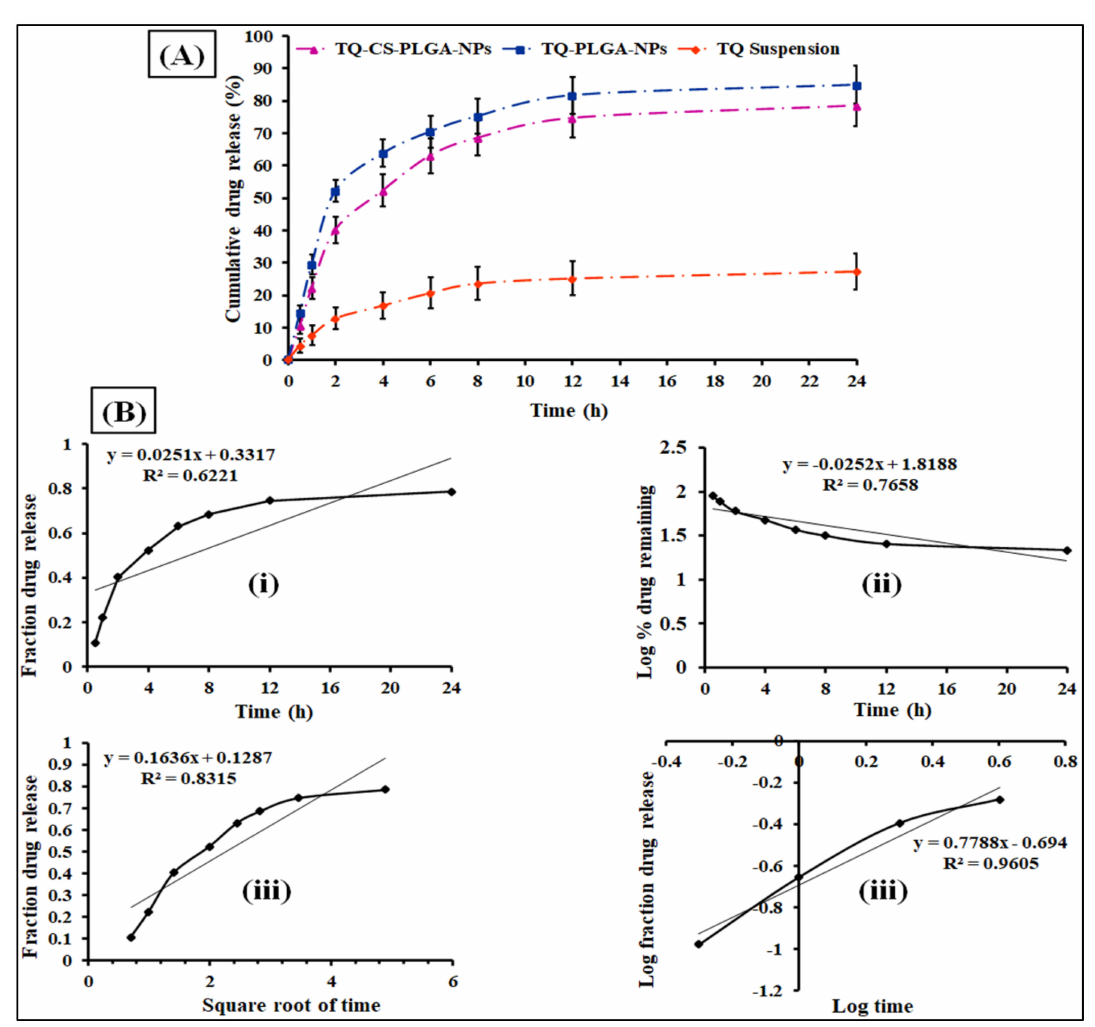
Figure 6. ( A ) Comparative in vitro release profiles of TQ-PLGA-NPs and TQ-CS-PLGA-NPs. Results are expressed as percentage mean ± SD ( n = 3). ( B ) In vitro release kinetics model to evaluate the mechanism of drug release from